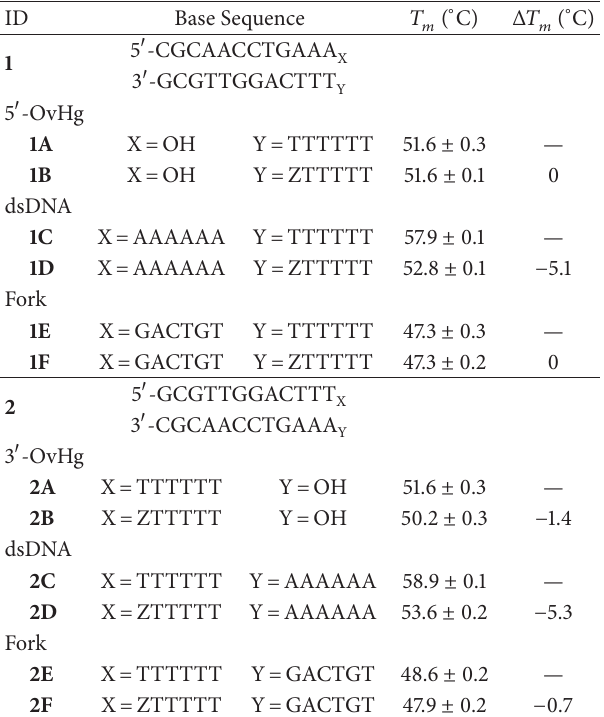
Table 1: Comparison of 𝑇 𝑚 values for unmodified and 3 containing DNA architectures relevant to replication. The position of 3 is indicated by